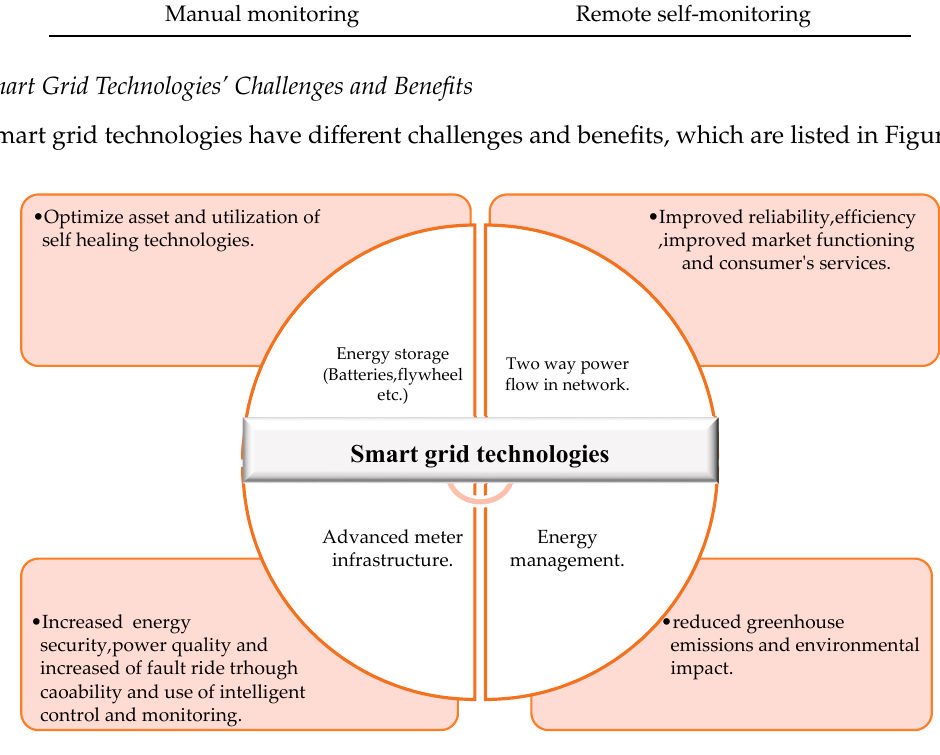
Figure 10 .Diagram of smart grid technologies’ challenges and benefits [29–32]. Figure 10. Diagram of smart grid technologies’ challenges and benefits